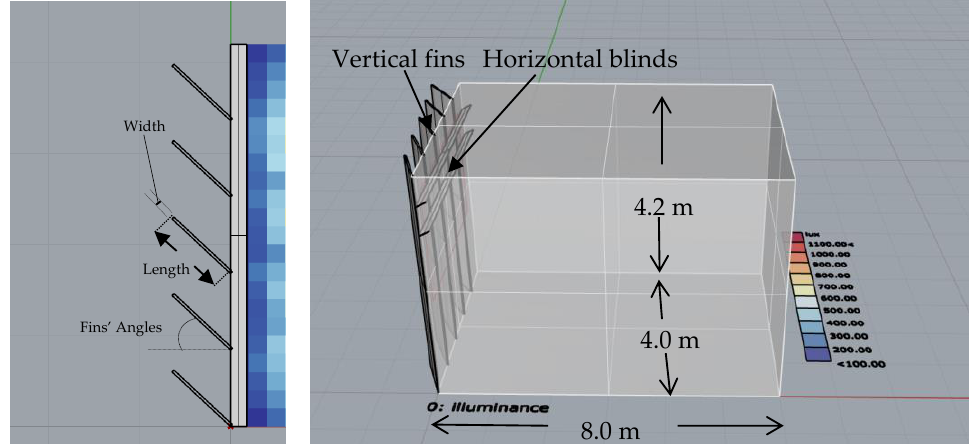
Figure 3. The test cell, the multi-angular vertical fins, and the horizontal responsive blinds (IKF).